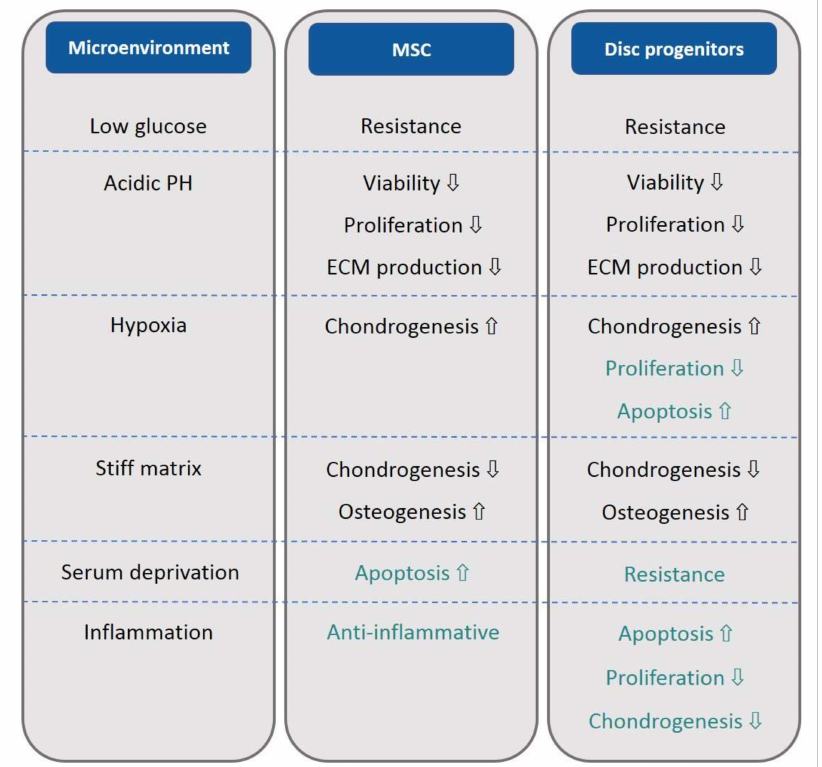
Figure 3. Summary and comparison of the behaviors of MSC and disc progenitors in IVD microenvironment. Behaviors in black indicate similar reactions, while behaviors in green indicate differential reactions, of MSC and disc progenitors to the microenvironmental factors. ECM: extracellular matrix. ⇩ indicates downregulation, while ⇧ indicates upregulation .